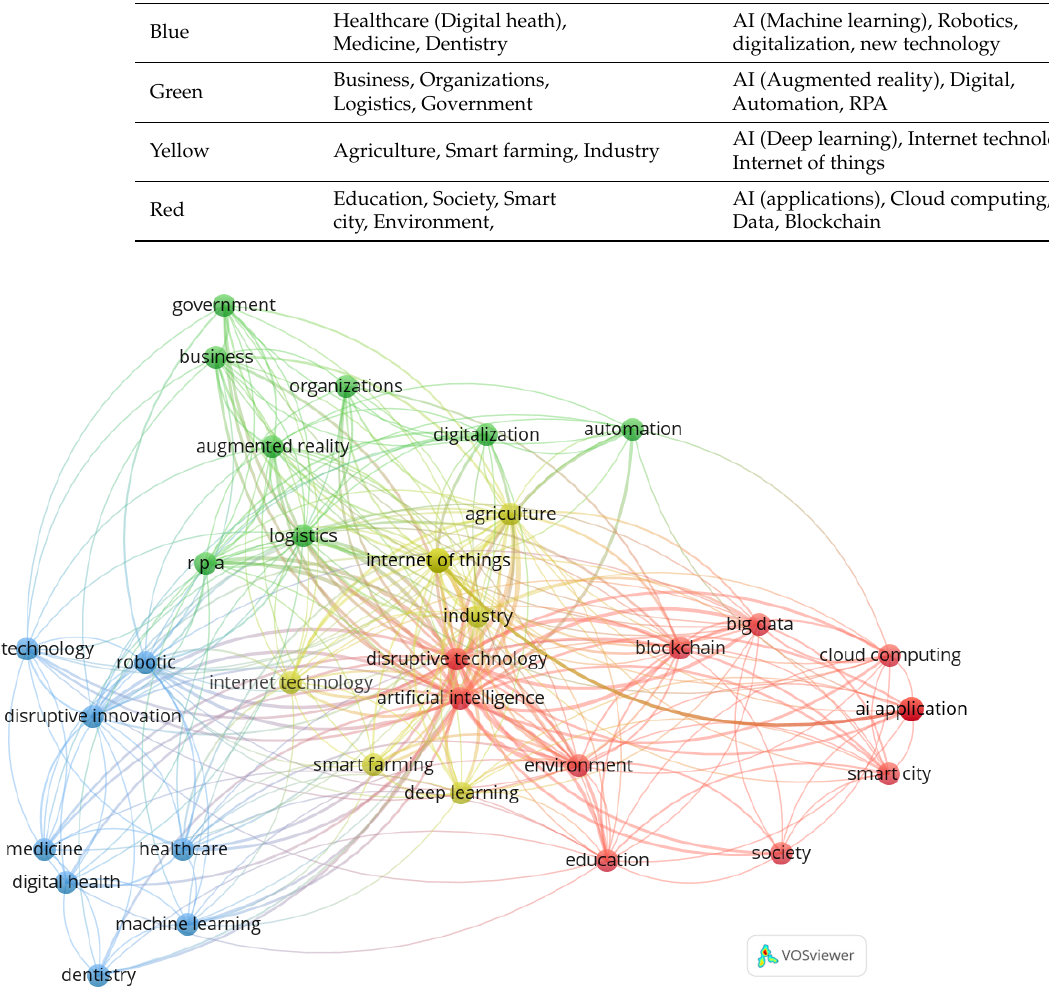
Figure 5. VOSViewer network map and clusters for technologies and impacted sectors. Based on the network map generated by VOSViewer (Figure 5) and the density vis- key domains were extracted. The results are stored in Table 2. Table 2. Cluster identification and domain- and technology-related keywords. Cluster